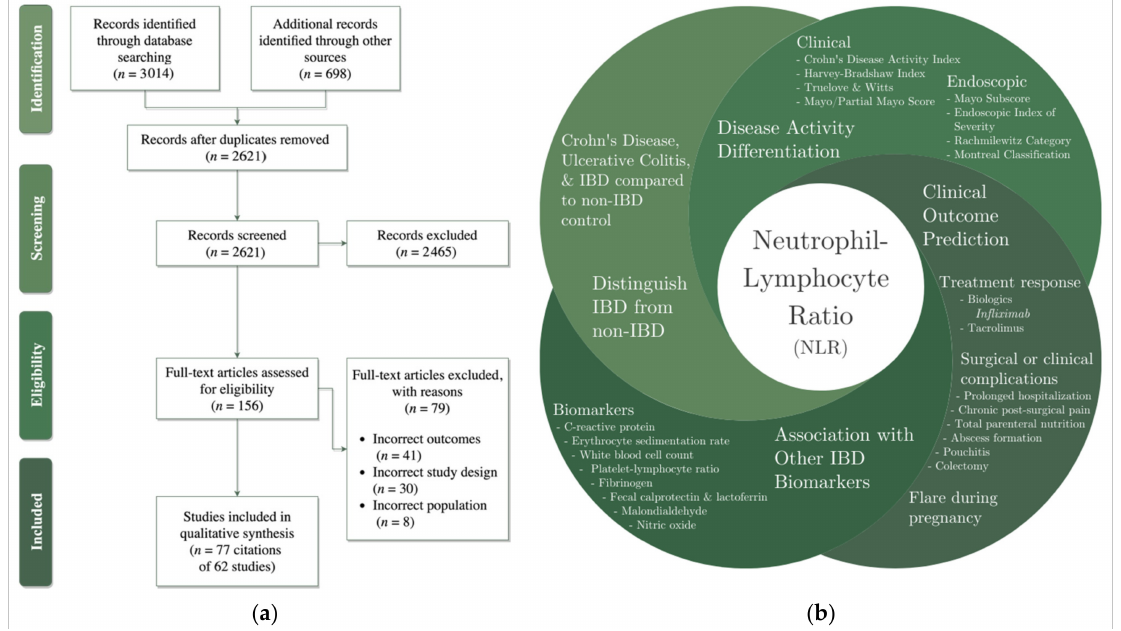
Figure 1. ( a ) PRISMA flow diagram of study selection; ( b ) identified categories of utility for neutrophil–lymphocyte